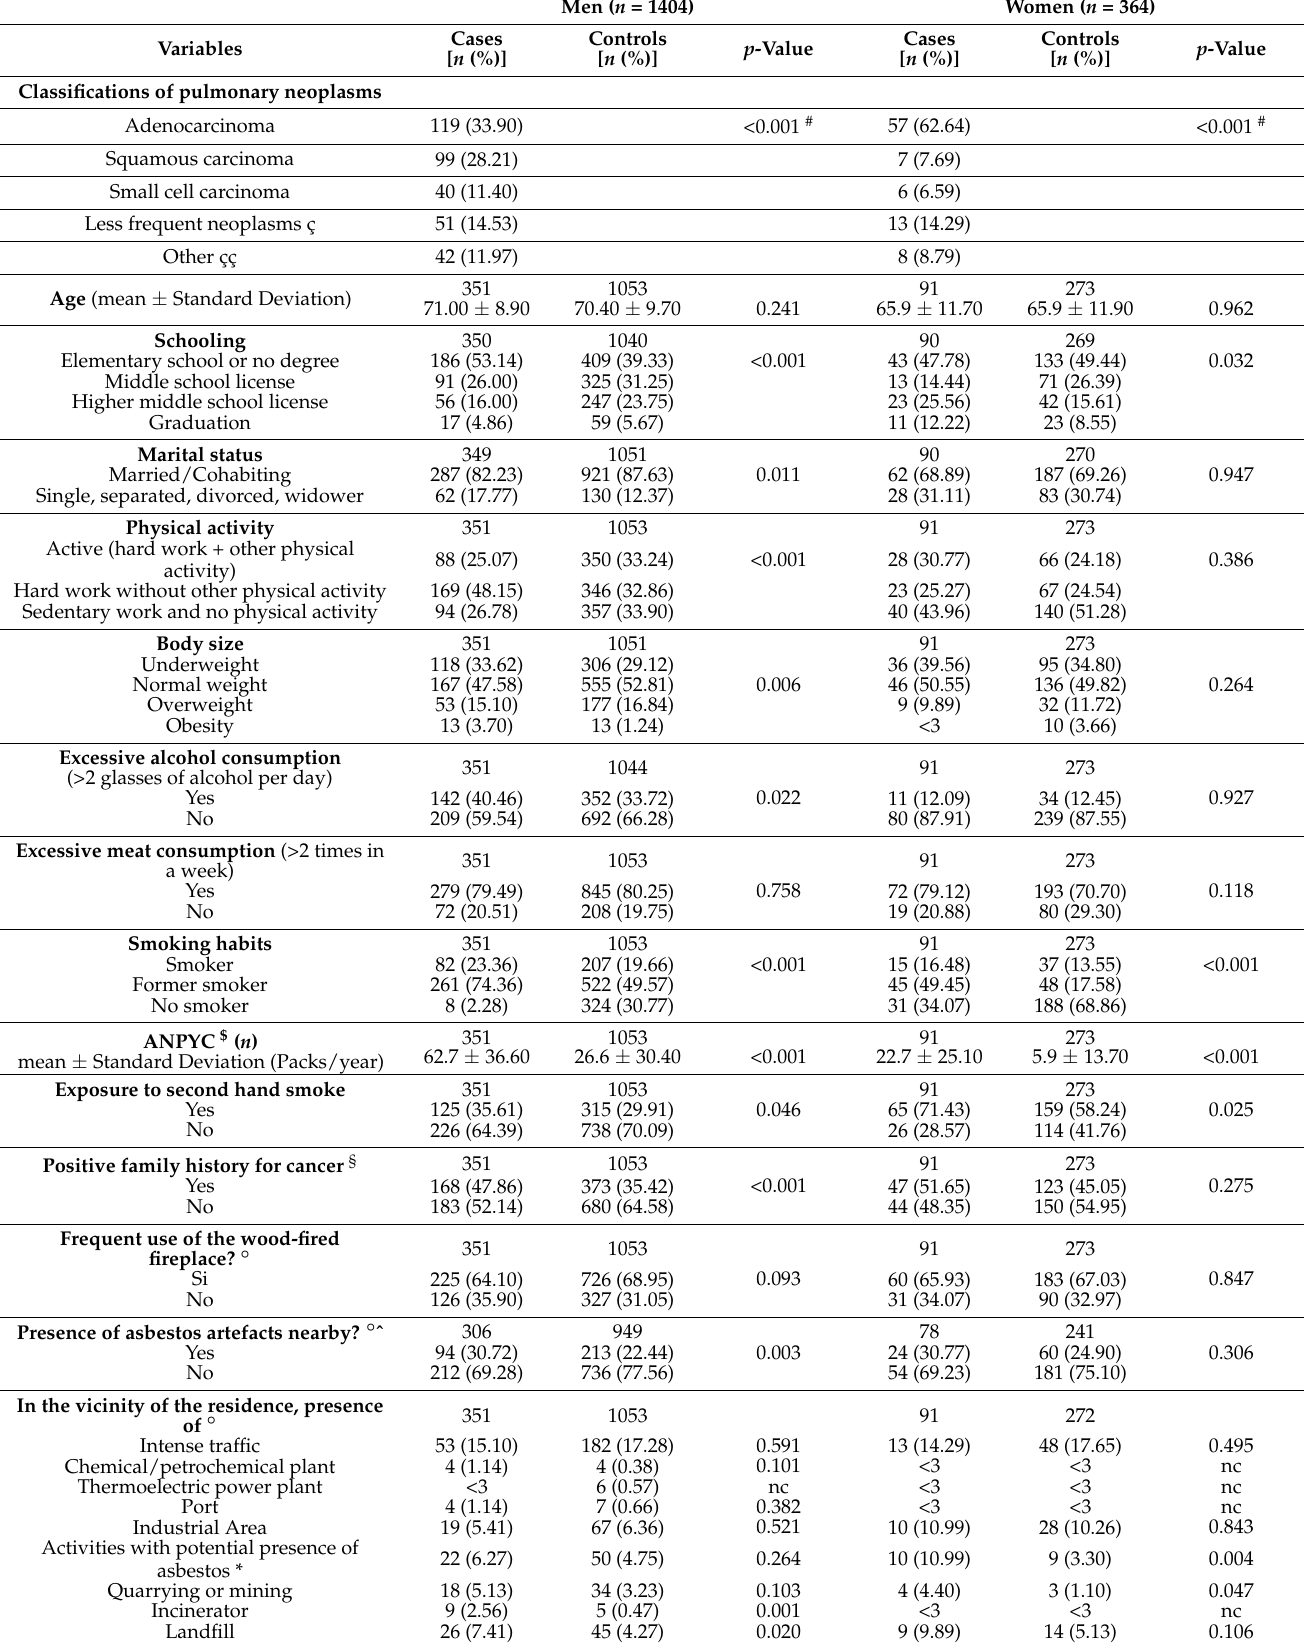
Table 3. General characteristics of the population under